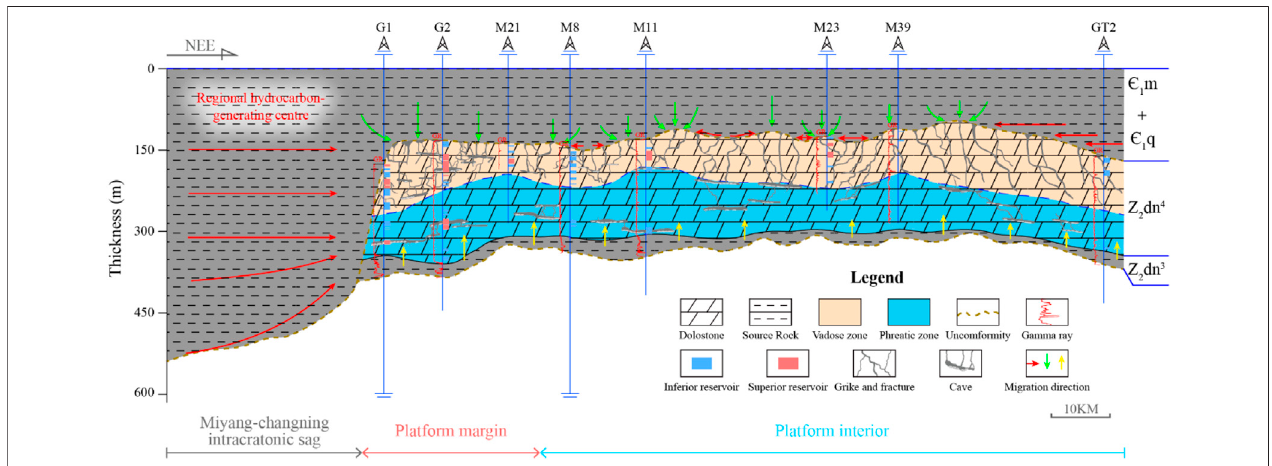
FIGURE 10 | Sketched map of hydrocarbon migration of the Z 2 dn 4 in the GMA. For the section location, see Figure 11 . Note that the inferior and superior reservoirs are compartmentalized by 5% porosity and 0.25 mD permeability.